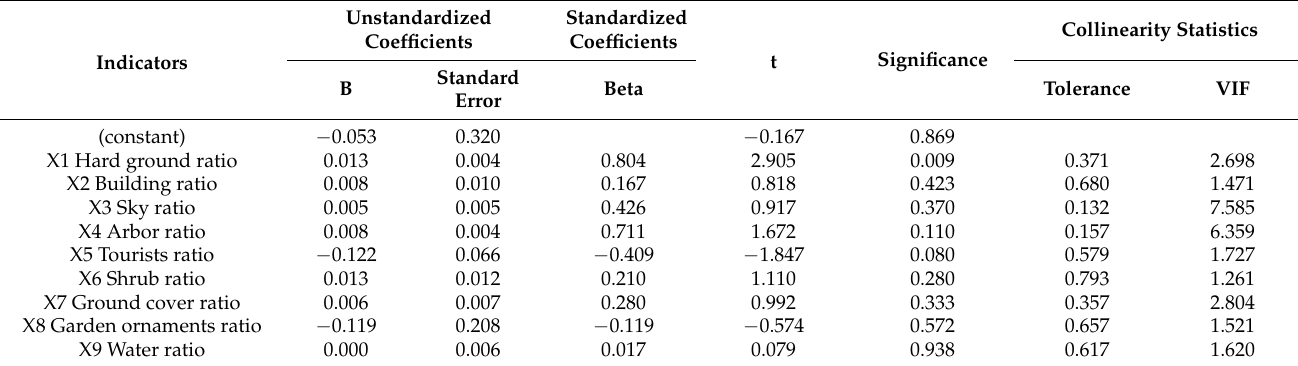
Table 6. Analysis of landscape elements affecting the